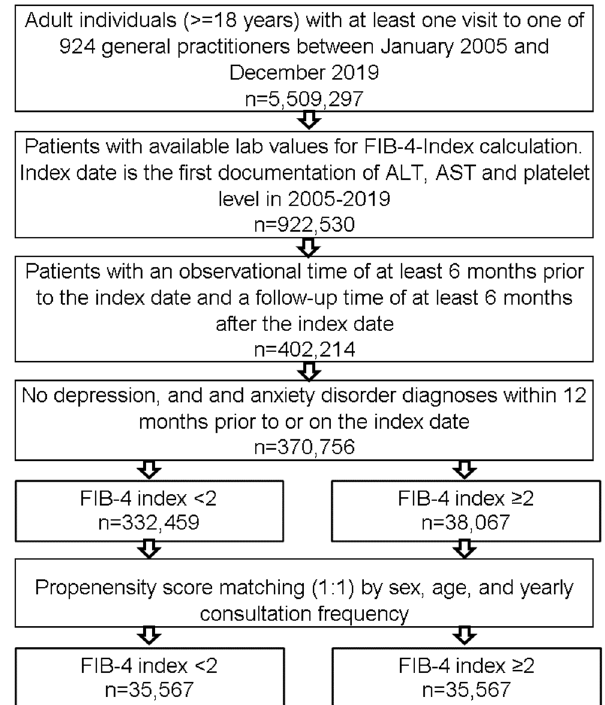
Figure 1. Selection of study patients.